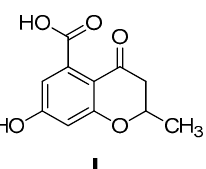
Figure 1. 7-Hydroxy-2-methyl-4-oxo-3,4-dihydro-2 H -benzopyran-5-carboxylic acid ( I ).